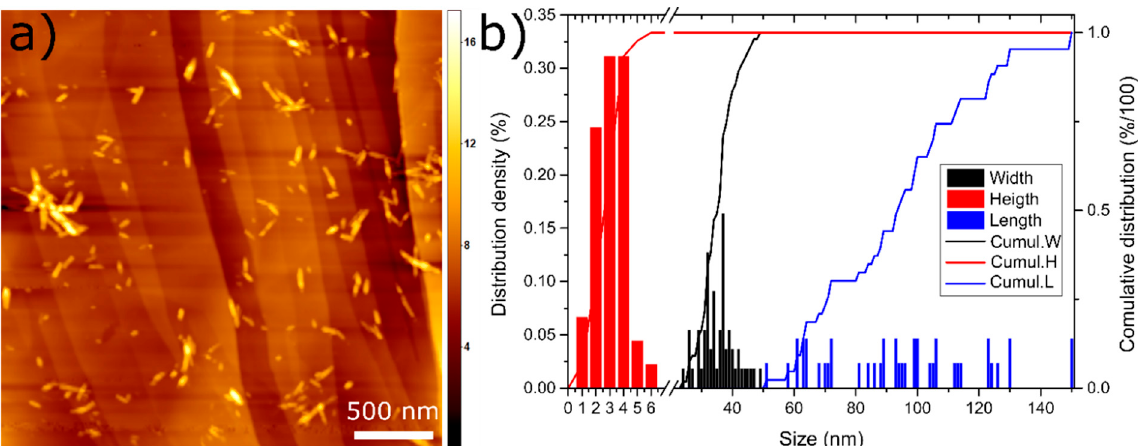
Figure 2. ( a ) AFM image of the nanocrystalline cellulose (NCC) on the highly oriented pyrolytic graphite (HOPG) surface. The scale bar is 500 nm, the legend on the right is in nm and shows the height of the particles; ( b ) distribution density and cumulative distribution for the width, height and length of the NCC particles.